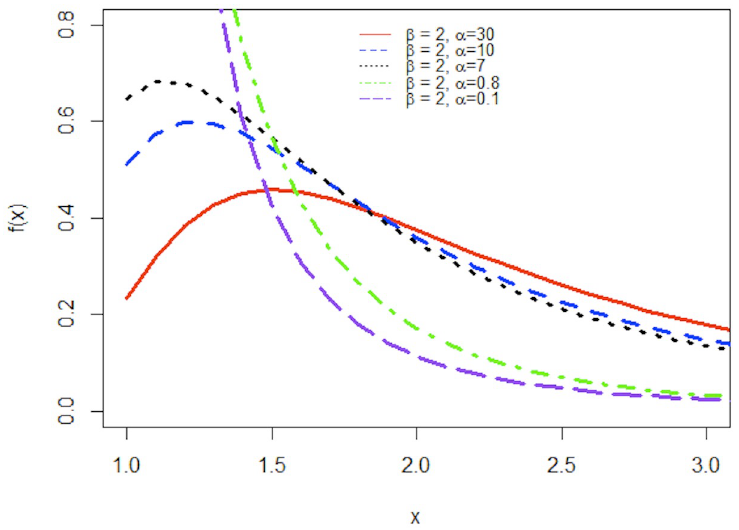
Fig 1. The PDF of APP distribution for various values of α and fixed β .